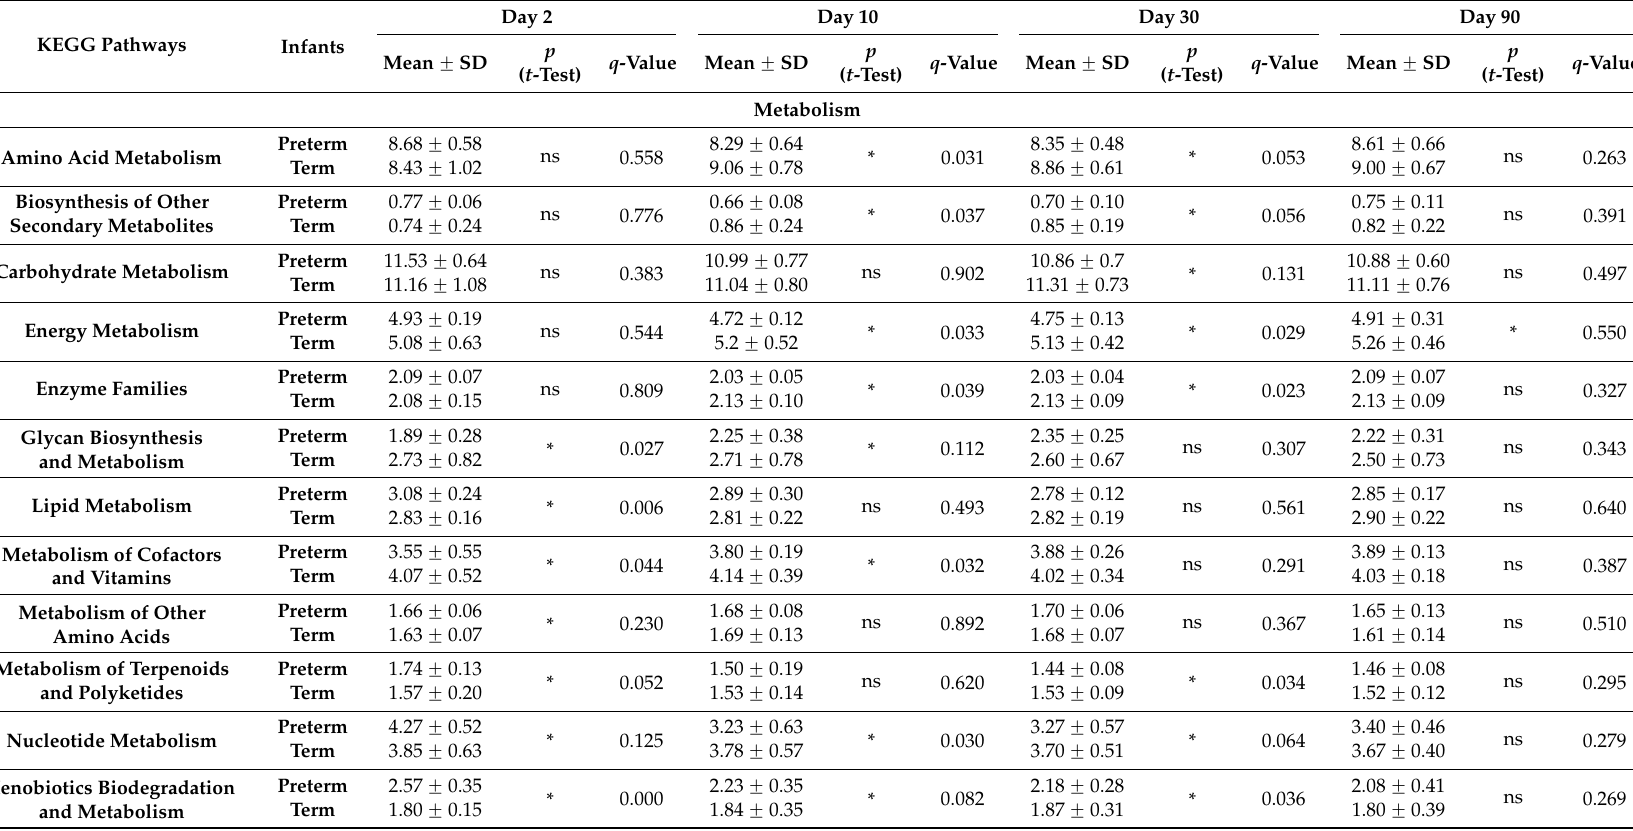
Table 1. Relative frequencies (mean ˘ standard deviation (SD)) at the different time points of Kyoto Encyclopedia of Genes and Genomes (KEGG) pathways (level 2) belonging to the categories that showed statistically significant differences between preterm and full-term infants. Asterisk denotes statistically significant differences ( p < 0.05 and q < 0.25) after Fañse Discovery Rate (FDR) correction; ns: Non-statistically significant